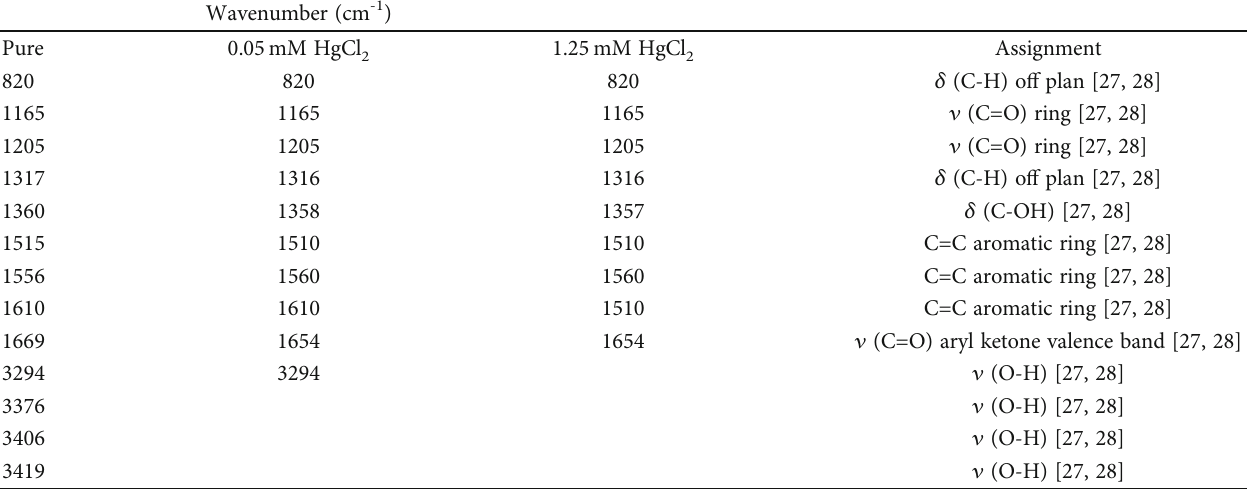
Table 2: Characterization of the most relevant FTIR peaks of pure quercetin and associated with mercury